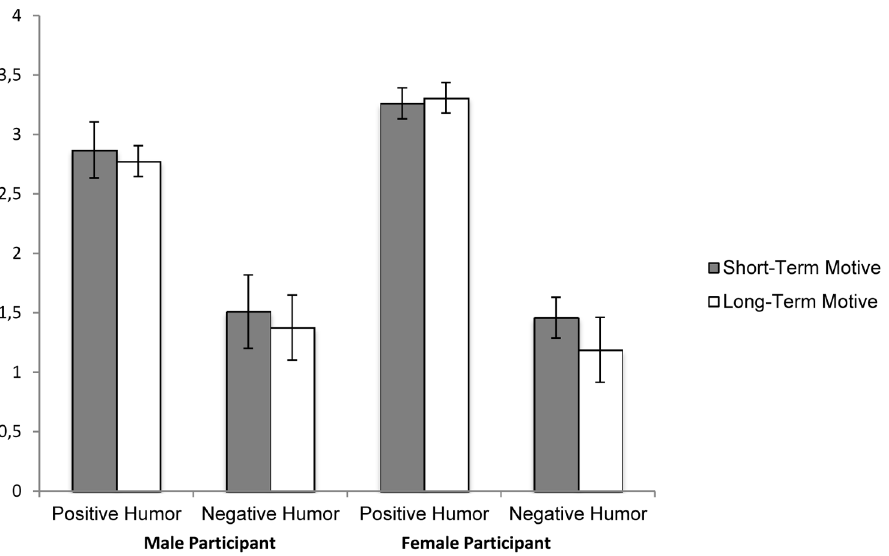
Figure 2. Changes in romantic interest (humor’s effectiveness) as a function of humor style, relational motive, and participant